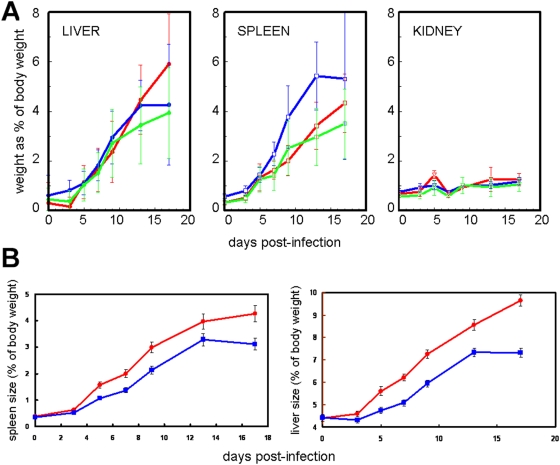
(A) Mean weights of internal organs relative to body weight during T. congolense infection in A/J mice (red), BALB/c mice (blue) and C57BL/6 (green) mice, shown as mean±SD. The mean relative weights of liver, spleen and kidney increased 1.9, 10.3 and 1.7 fold over the course of the infection (p<0.001). There were statistically significant (ANOVA p<0.05) differences in weight between strains at most time points but the largest and perhaps biologically most significant difference was in the spleen where the relative weight in BALB/c mice increased 12 fold and in A/J and C57BL/6 mice it increased about 9.4 fold. (B) The increase in mean spleen and liver weights (±StErr) is higher in female (red, circles) than male (blue, squares) mice (p<0.001).